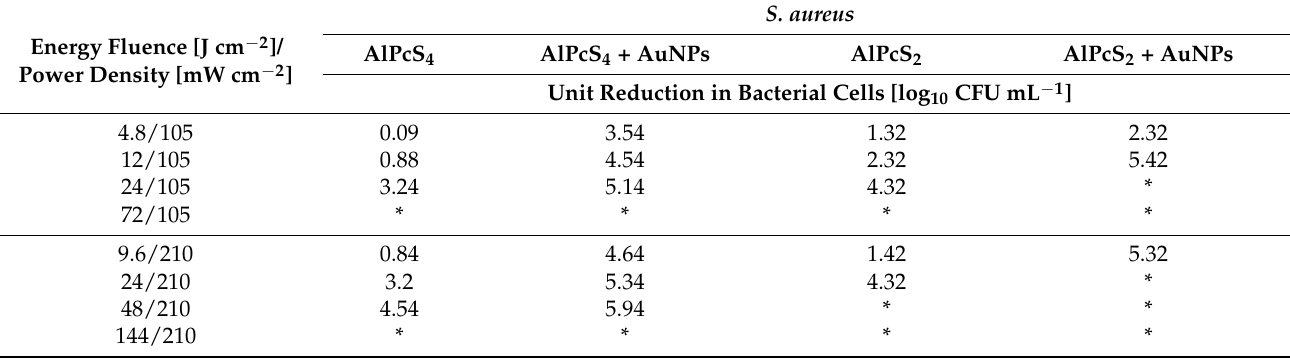
Table 1. The relationship between energy fluence [J cm − 2 ]/power density and S. aureus cell mortality rate [log 10 CFU/mL].